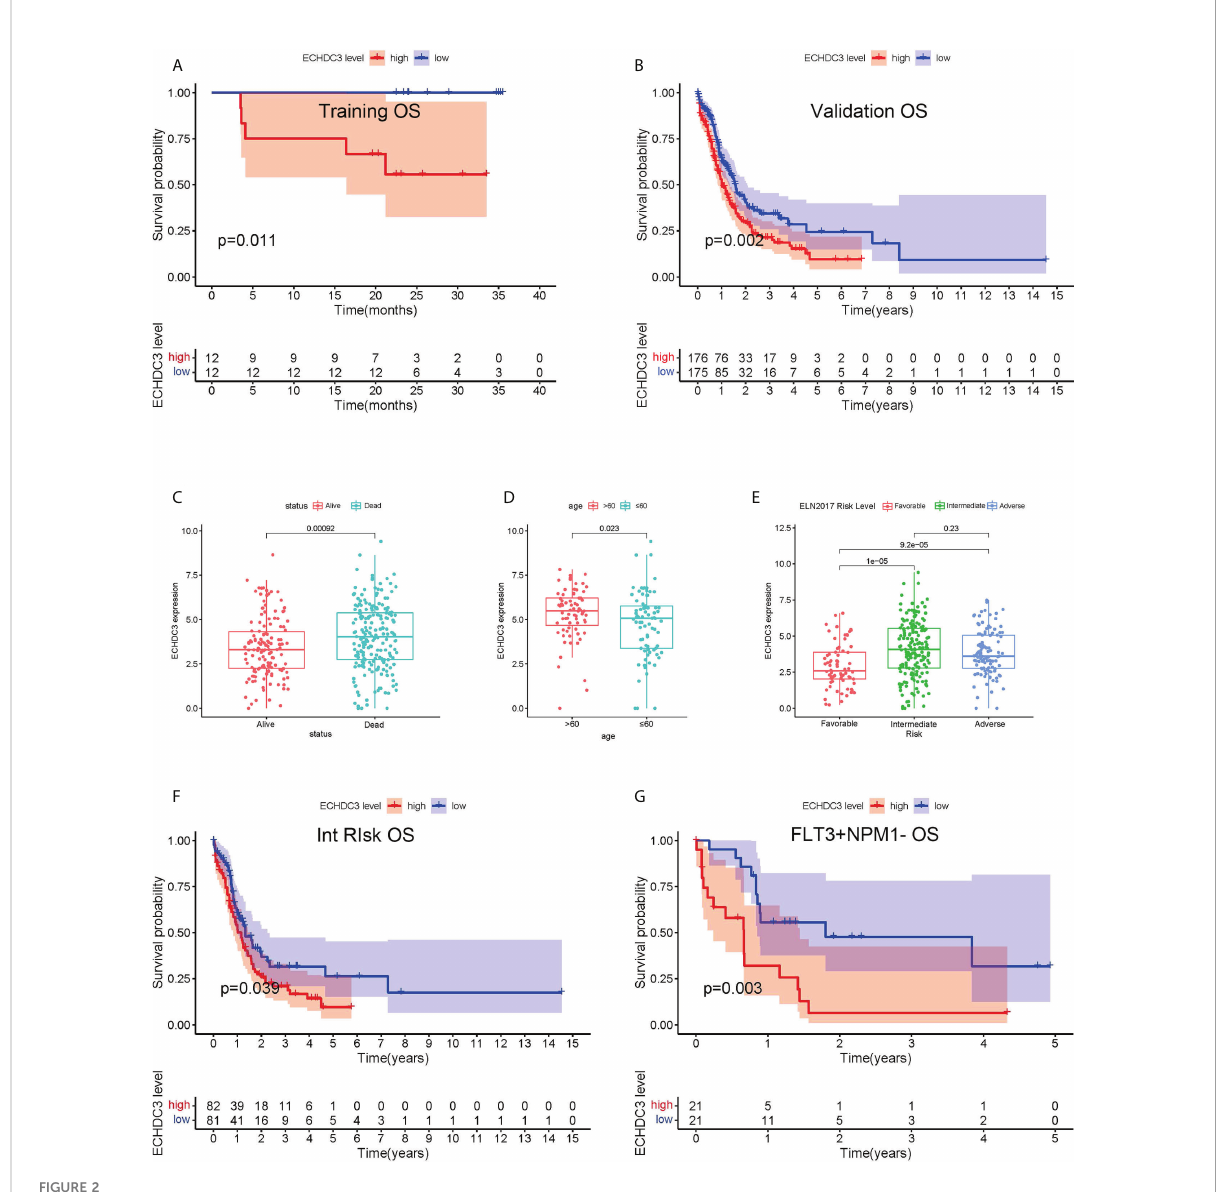
FIGURE 2 Prognostic value of ECHDC3 expression in training and validation. (A) Overall survival of non-APL AML patients in the training cohort ( de novo AML patients). (B) Overall survival of non-APL AML patients in validation sets (TCGA-LAML and BEAT-AM bone marrow samples). (C) ECHDC3 expression in subgroups of alive and dead patients in validation sets. (D) ECHDC3 expression in subgroups of age >60 and age <=60 in validation sets. (E) ECHDC3 expression in subgroups of fav, int, and adv ELN risk in validation sets. (F) Overall survival of ELN int-risk AML in validation sets. (G) Overall survival of FLT3+NPM1 − AML in validation